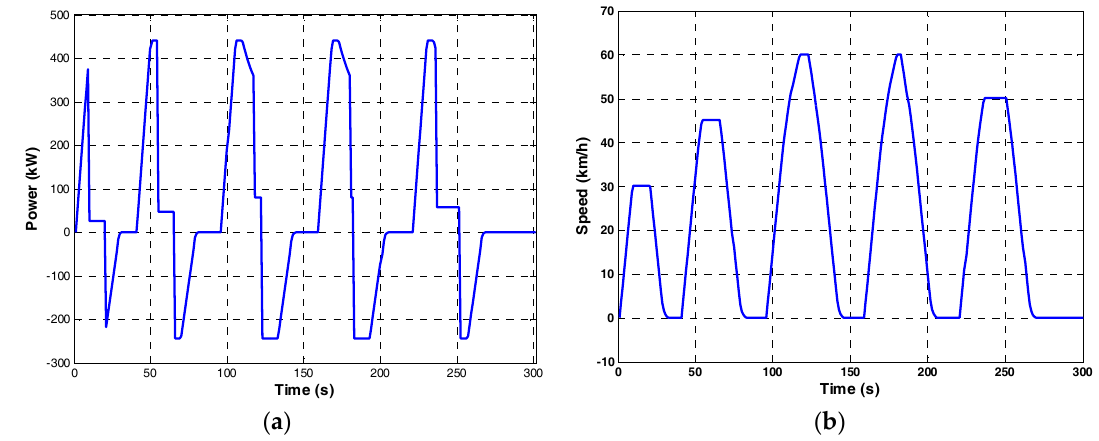
Figure 6. Mechanical power and speed profile of a train traveling on the railway: ( a ) Mechanical power necessary by the train; and ( b ) Train speed along the track.